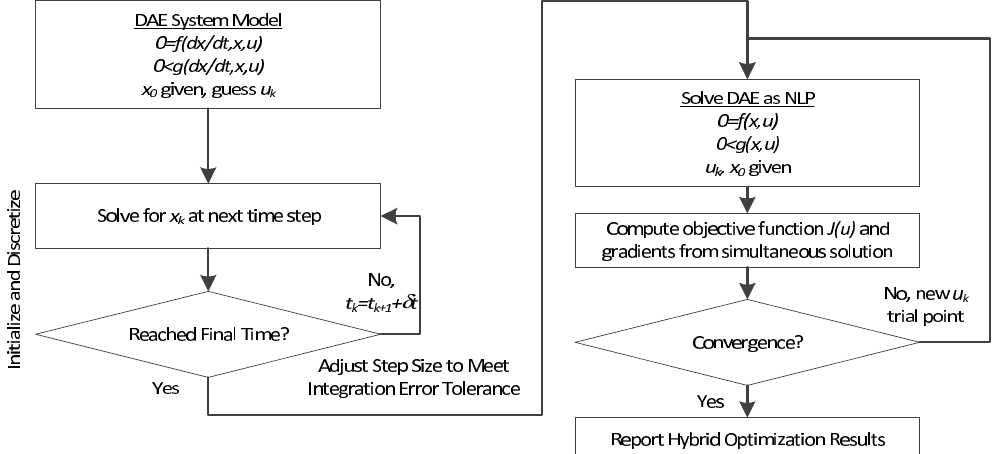
Figure 6. Overview of the hybrid approach to initialize and optimize DAE systems with initialization on the left followed by optimization on the